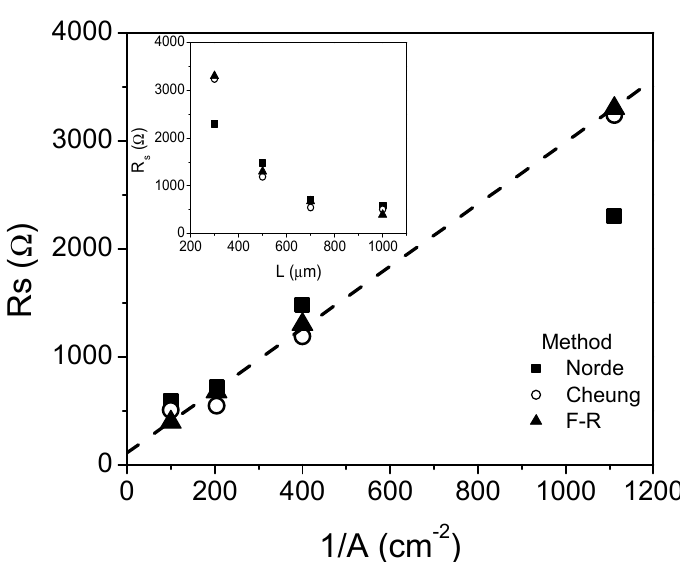
Figure 4. Comparison of the extracted values of the series resistance using the different methods.